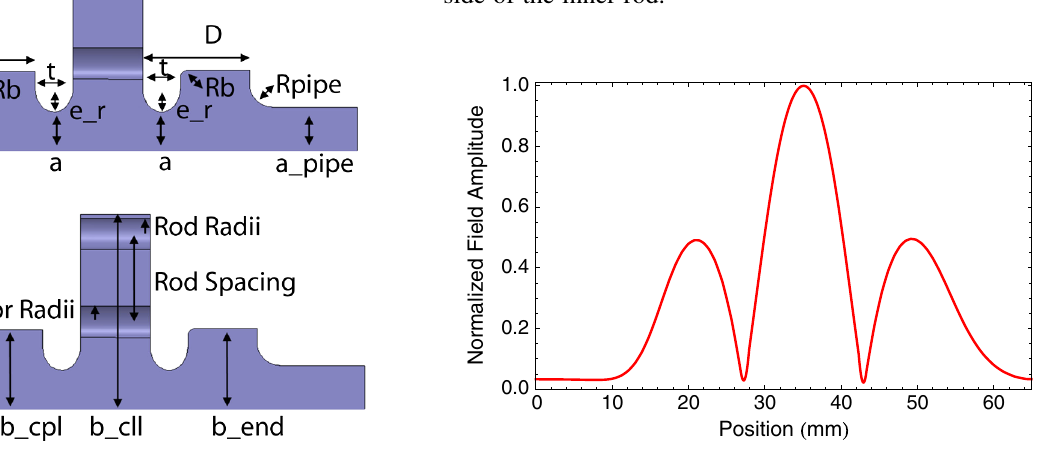
FIG. 3. Axisymmetric views of the vacuum space of the PBG- E structure showing the fixed parameters (a), and tuning pa- rameters (b), for the elliptical-rod PBG structure.